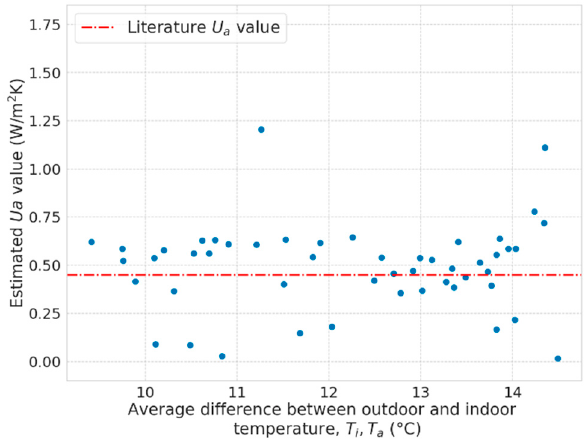
Figure 12. Estimated Ua values and the average difference between outdoor and indoor temperature.